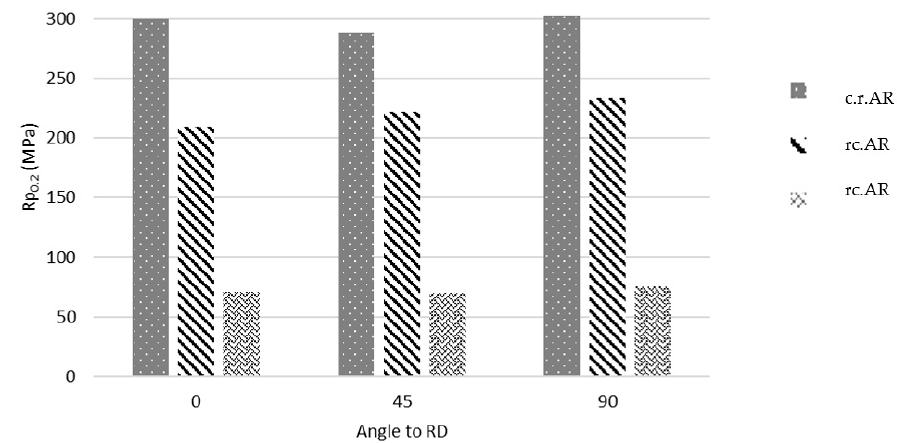
Figure 2. Yield strength of the samples depending on their relative angle to RD.